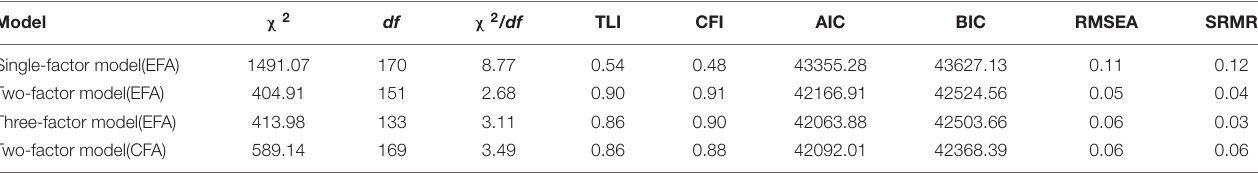
TABLE 1 | The goodness-of-fit indices of the factor analysis models.